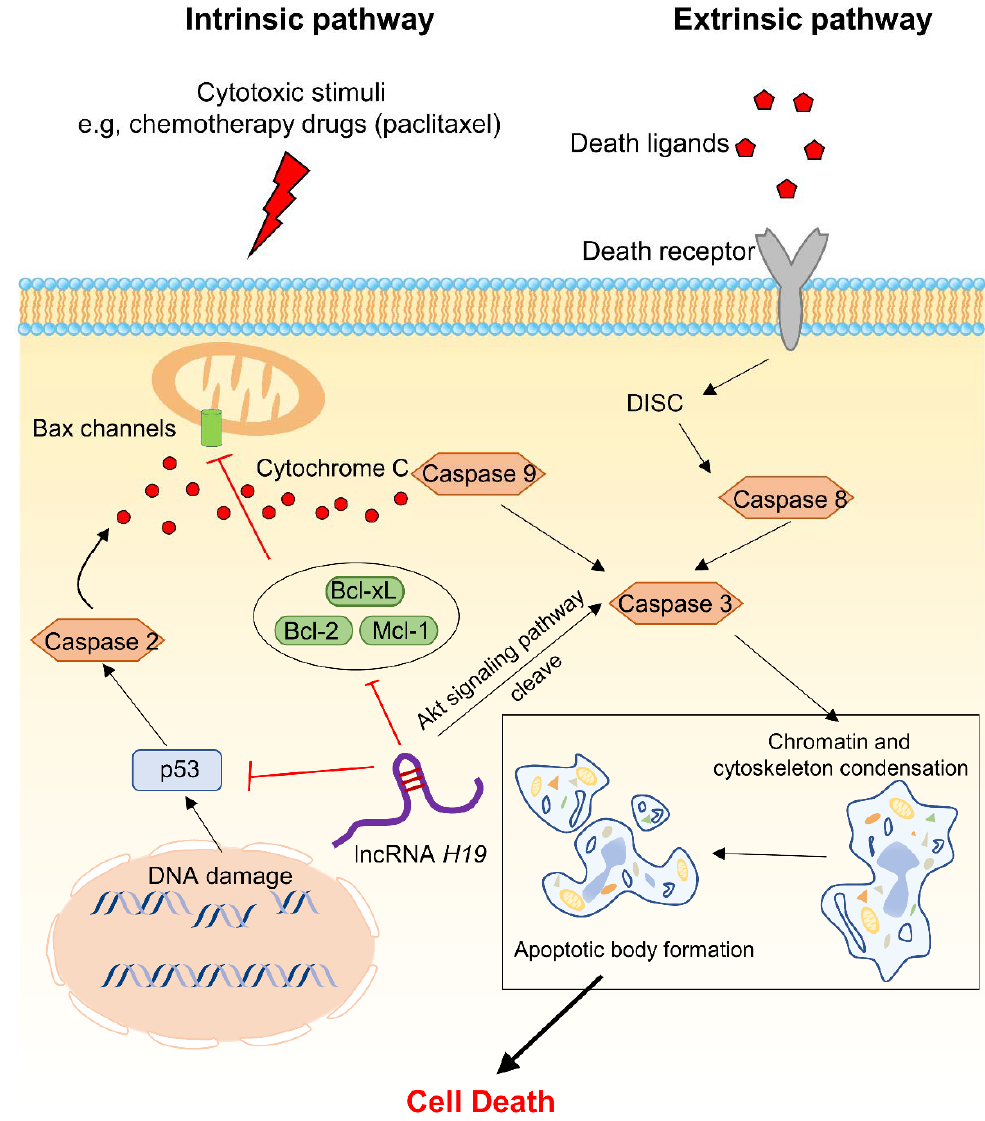
Figure 3. Overview of the apoptosis pathways (lncRNA H19 is used as example clarifying the mechanism). The intrinsic pathway of apoptosis is initiated by the cell itself in response to cytotoxic stimuli. The extrinsic pathway is initiated via death receptors stimulated by death ligands. When caspase 3 is activated, the two pathways merge and lead to cell death [38]. Bax channels, Bcl-2-associated protein X channels; Bcl-2, B-cell lymphoma 2; Bcl-xL, B-cell lymphoma extra-large; Mcl-1 induced myeloid leukemia cell differentiation protein 1; DISC, death inducing signalling complex. Table 1. The role of lncRNAs in regulating cell survival and death in chemoresistance breast cancers.